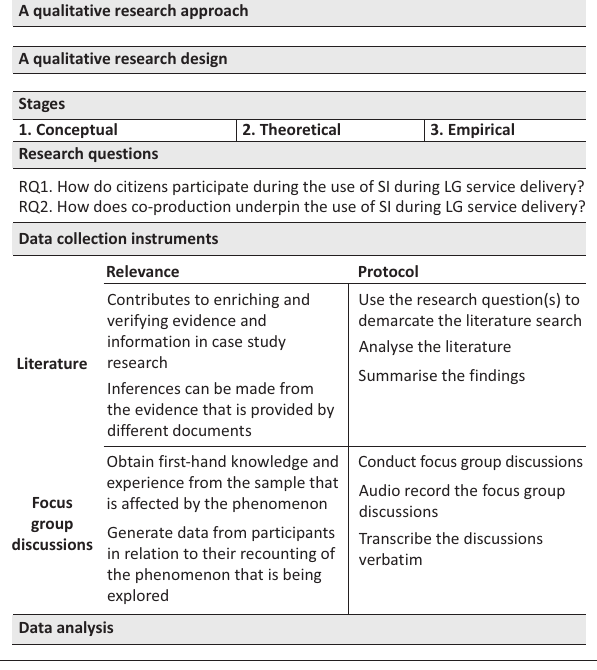
FIGURE 1: Stages of the qualitative research